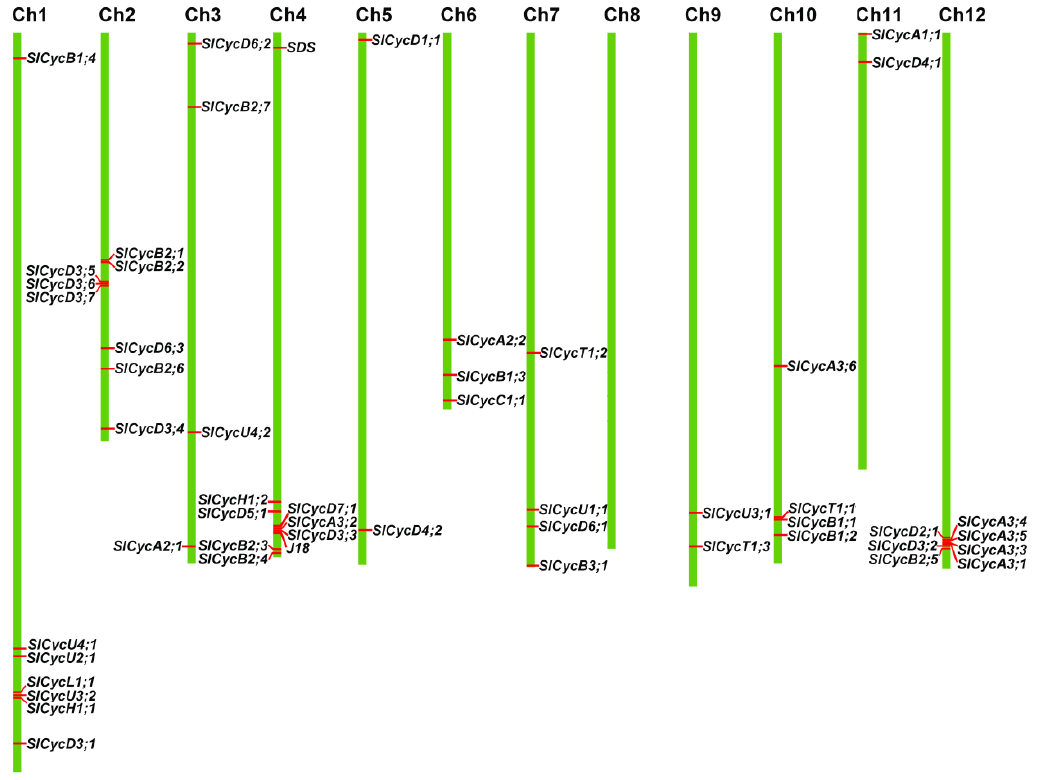
Figure 5. Genome-wide distribution of cyclins on tomato chromosomes. Gene identity numbers are provided. Chromosome numbers are indicated at the top of each